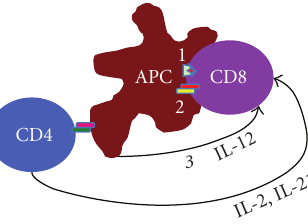
Figure 2: Successful activation of CD8 T cells requires three signals by APCs and CD4 T cell help. CD8 T cells engage cognate peptide- MHC complexes presented on APCs with their TCR (1). The APC also provides costimulation to the T cell via expression of CD80/CD86 molecules, which bind to CD28 on the T cell (2). Finally, the APC produces IL-12 after activation with inflammatory mediators or in response to CD40L interactions with CD4 T cells, and IL-12 provides signal 3 to the responding CD8 T cell. (3) CD4 T cells also produce cytokines that provide growth and di ff erentiation signals to responding CD8 T